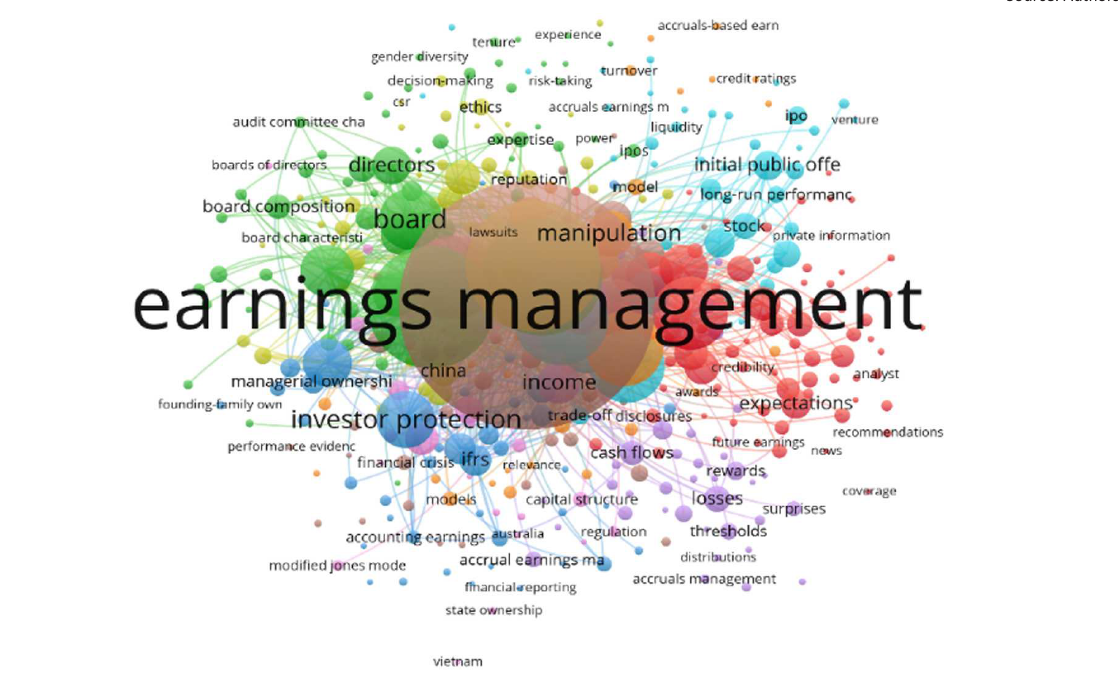
Figure 4. Keyword science maps for Earnings Management,